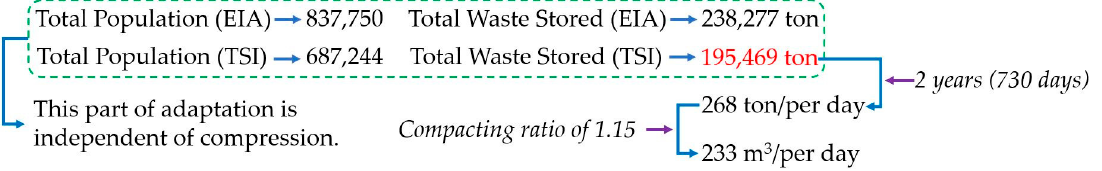
Figure 8. Obtaining per-day volume value by using statistical values in the comparison.